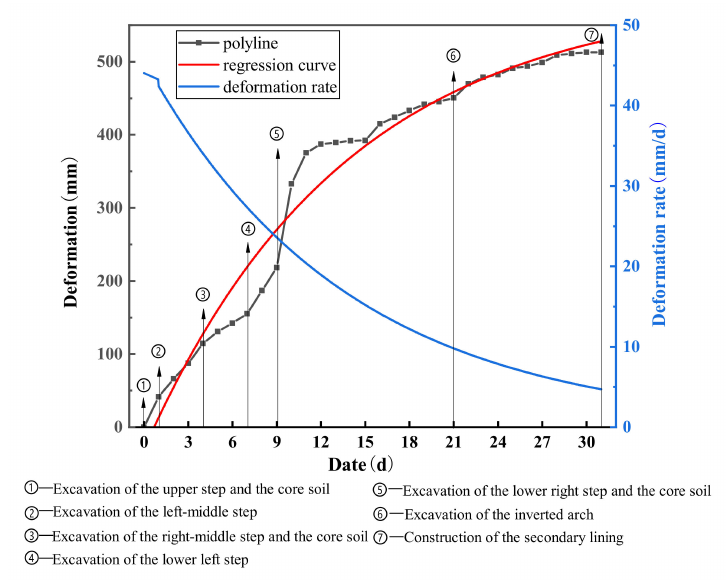
Figure 19. Deformation analysis diagram of the vault of the YK280+216 section of the tunnel.